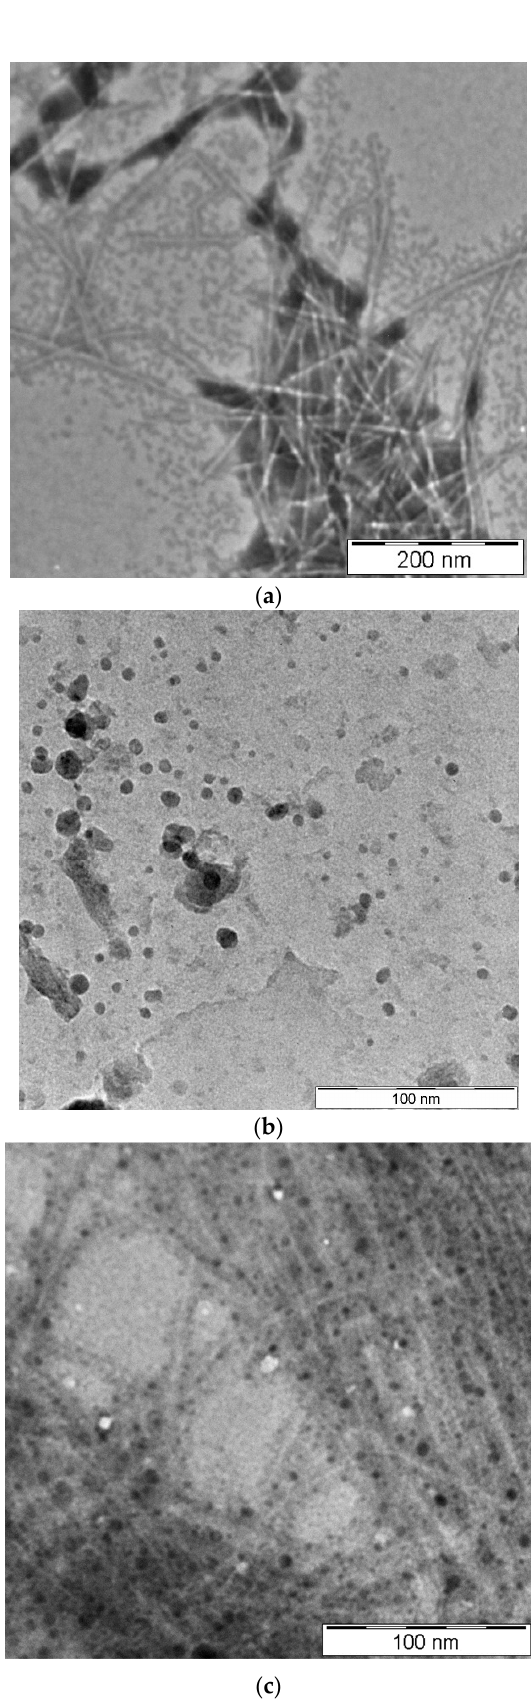
Figure 1. TEM images of ( a ) CNCs, ( b ) IONPs, and ( c ) magnetic CNCs.